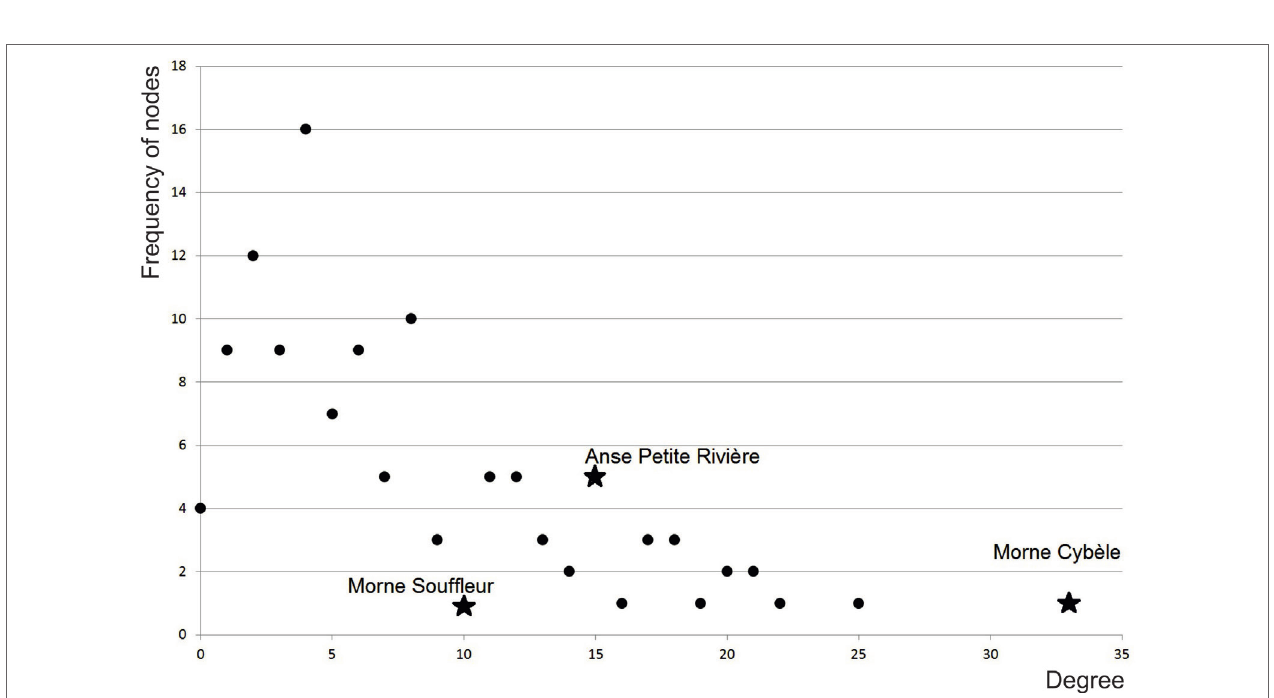
FigUre 4 | Geographical (a) and network (B) data representation of total viewshed results, where each node in the landscape is represented by a node and pairs of nodes are connected by an edge if this pair of locations is connected by a line-of-sight. This figure presents a purposely coarse resolution total viewshed experiment to better illustrate the